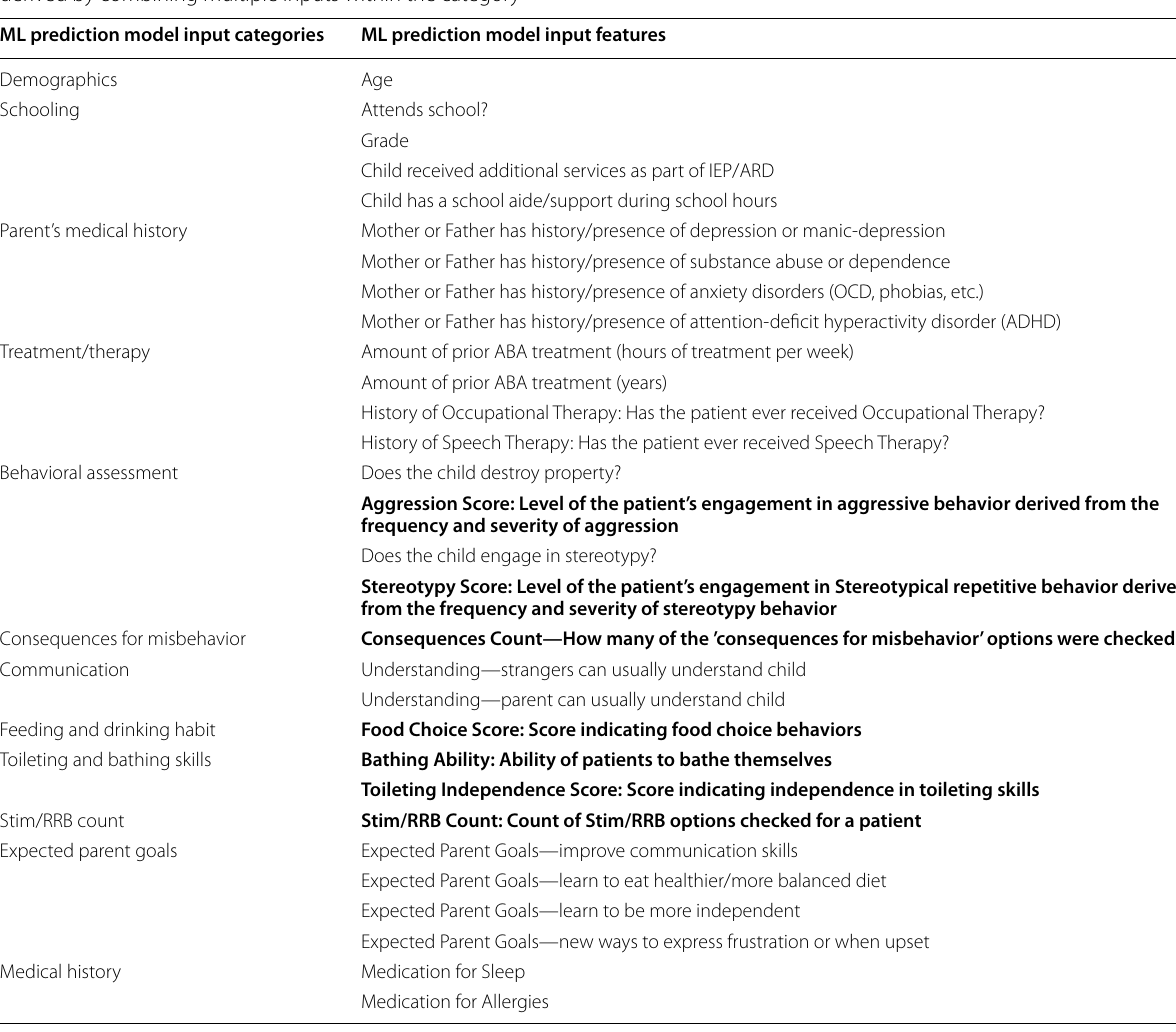
Table 1 List of input features used to train the machine learning prediction model. The table also shows the type or category (e.g., demographics, schooling information, parent’s medical history, past treatment and therapy, behavioral assessments, etc.) of the input features, and is a subset of all available inputs (shown in Additional file 1: Table S1). The input features were selected from the larger list of features by using the feature selection process described in the Methods section (and outlined in Fig. 1). Inputs in bold font were derived by combining multiple inputs within the